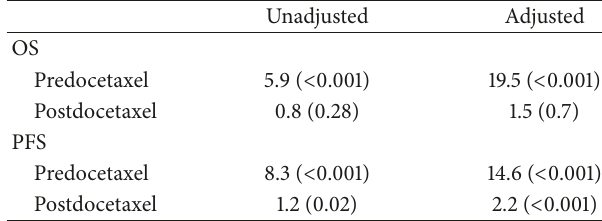
Table 3: Enzalutamide advantage over abiraterone (without and with adjustment for baseline Gleason score) in months ( 𝑝